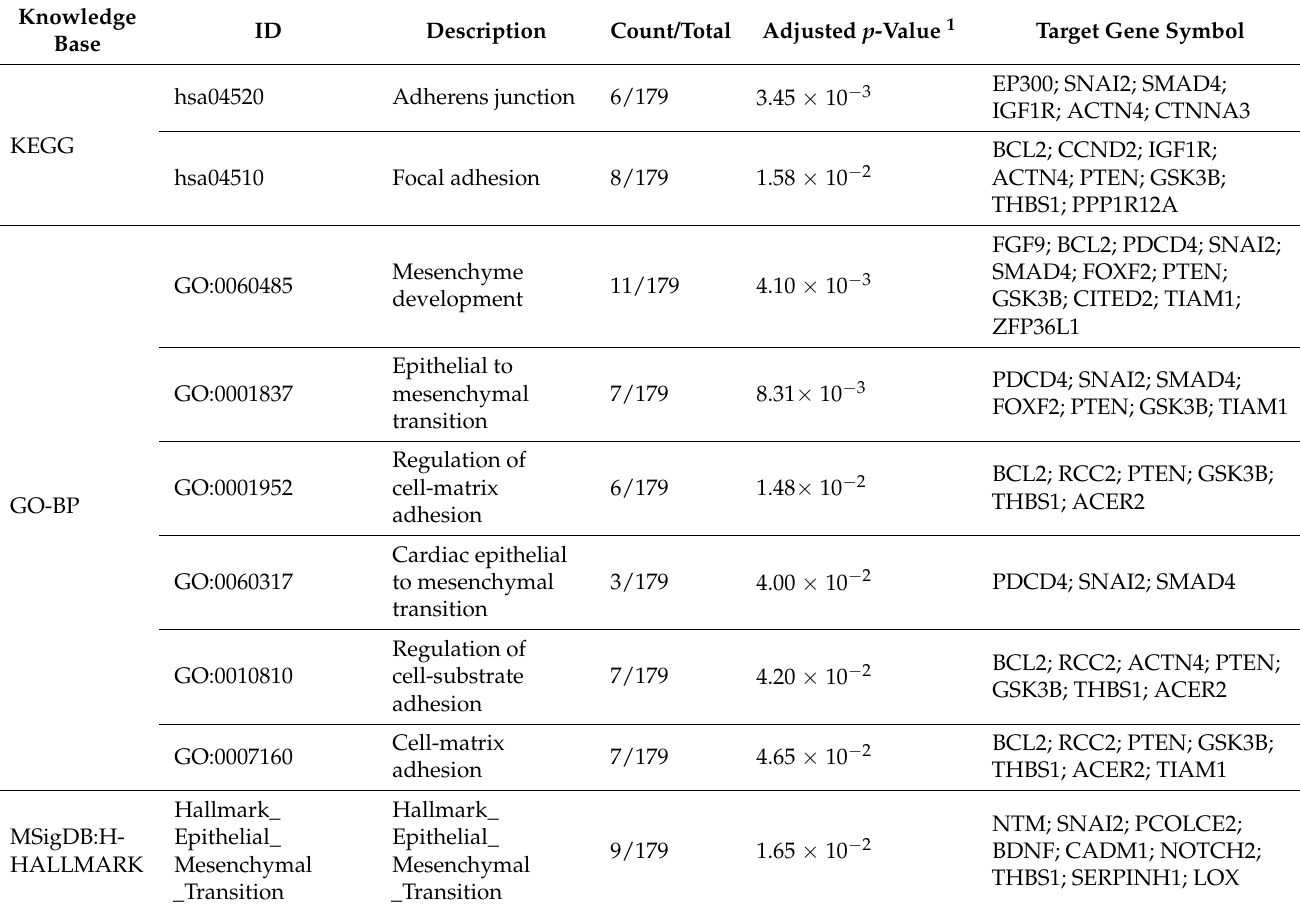
Table 2. Functional enrichment analysis of miR-182 related to EMT. Table shows the significant association of miR-182 target genes with Gene Set descriptions related to EMT. Analysis performed using clusterProfiler in